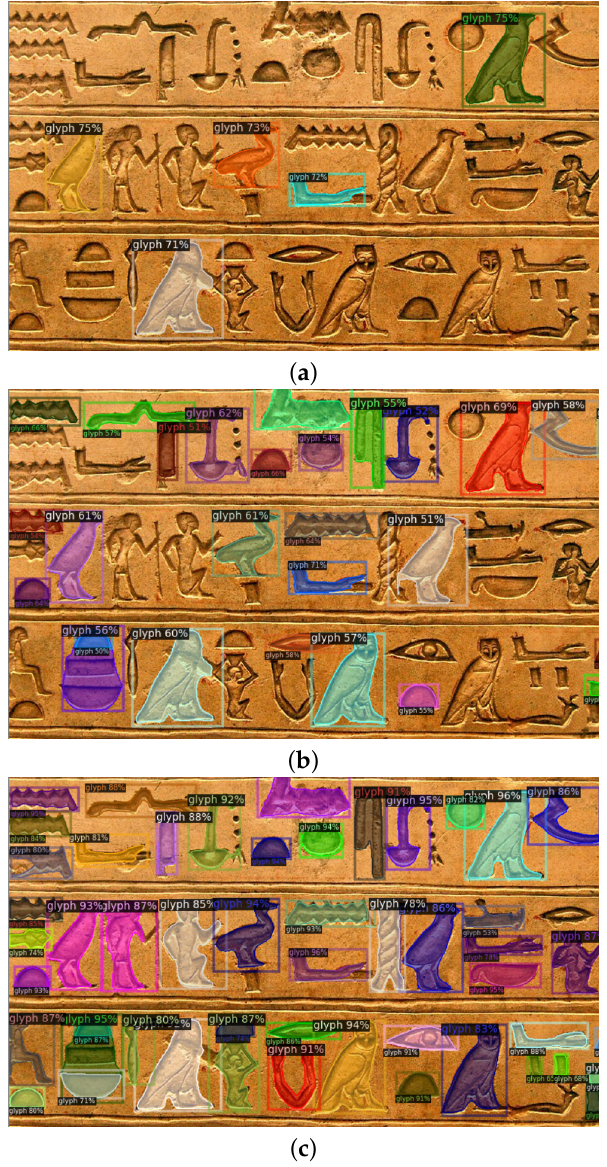
Figure 4. Segmentation results obtained after 300 epochs and objectness score threshold equal to 0.7 ( a ); after 300 epochs and objectness score threshold equal to 0.5 ( b ); and after 500 epochs and objectness score threshold equal to 0.5 ( c